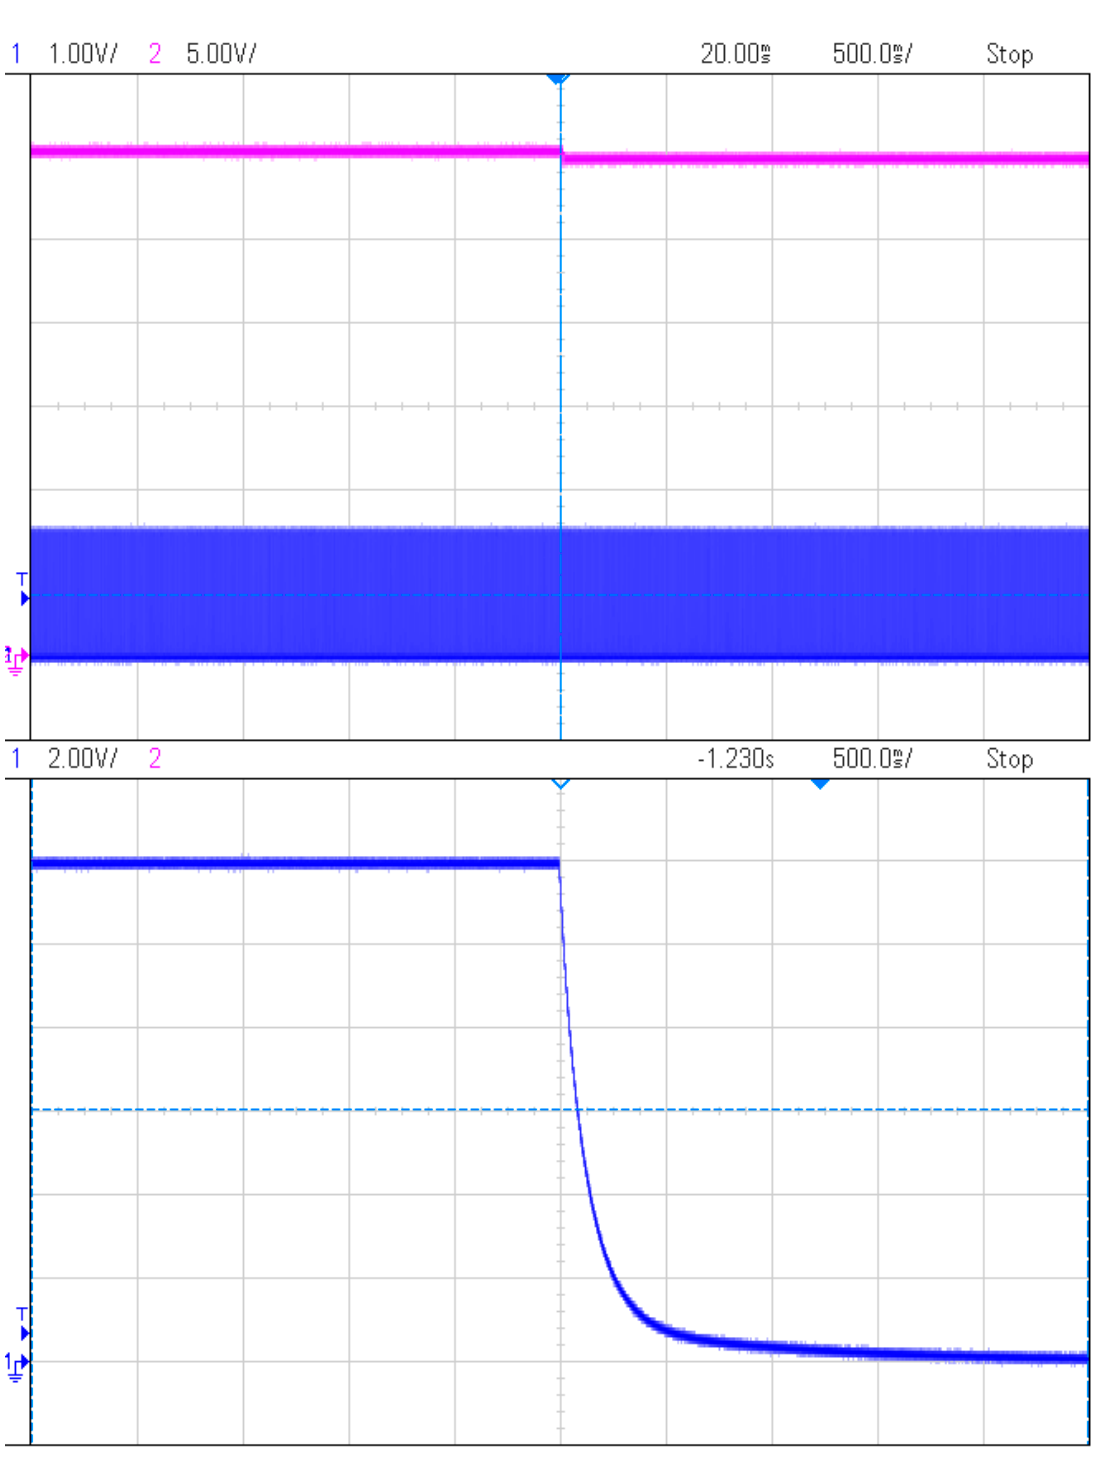
Figure 12. Experimental behavior for PI closed-loop, with additional failure events in e 2 . Output voltage (upper plot), PWM (middle plot), and e 2 (bottom plot)